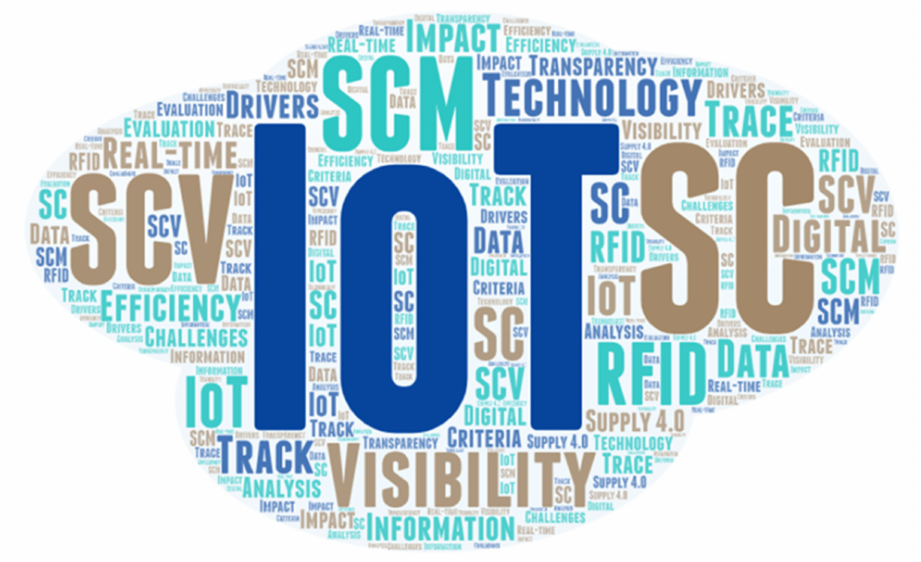
Figure 7. Word cloud showing key themes within the articles.